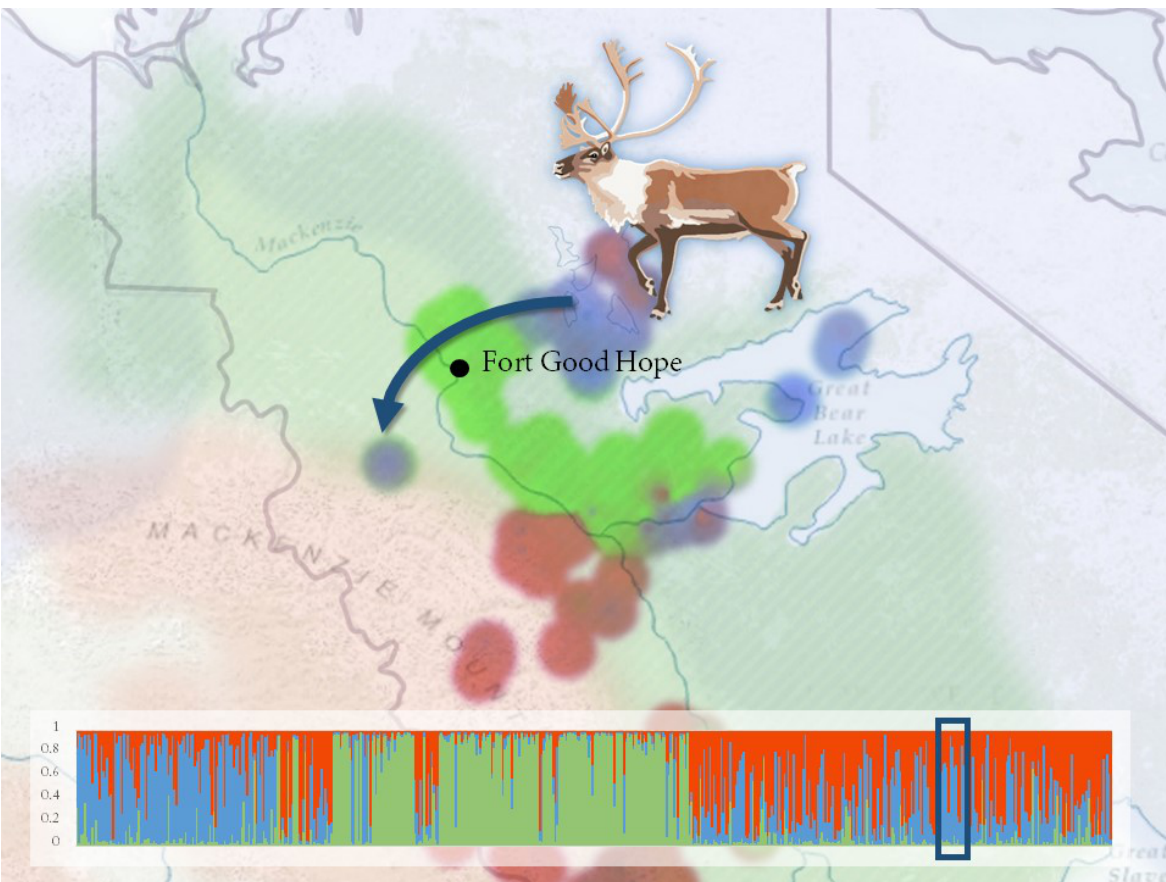
Figure A2.4. During a focus group meeting, Gabe Kochon of Fort Good Hope, Northwest Territories, Canada, described a historic event where a large herd of caribou crossed the Dehcho (Mackenzie River) and headed into the foothills of the mountains many years ago. We collected samples from the area identified by the arrow during our 2 April 2014 helicopter survey and identified 9 individual caribou from the site in subsequent genetic analysis. Structure analysis of these samples found a high probability of assignment (average 0.73) to the barren-ground caribou cluster (shown as blue in bottom bar and represented as blue on the map). Genetic structure analysis identified k=3 clusters of 1) barren-ground (blue) 2) boreal woodland (green) and 3) mountain